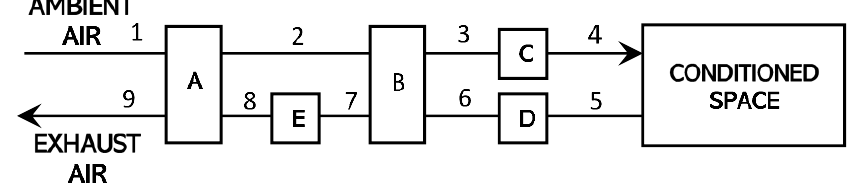
Figure 1. Solid-desiccant evaporative cooling system. A: desiccant wheel, B: energy-recovery wheel, C and D: evaporative cooler, E: regeneration source.